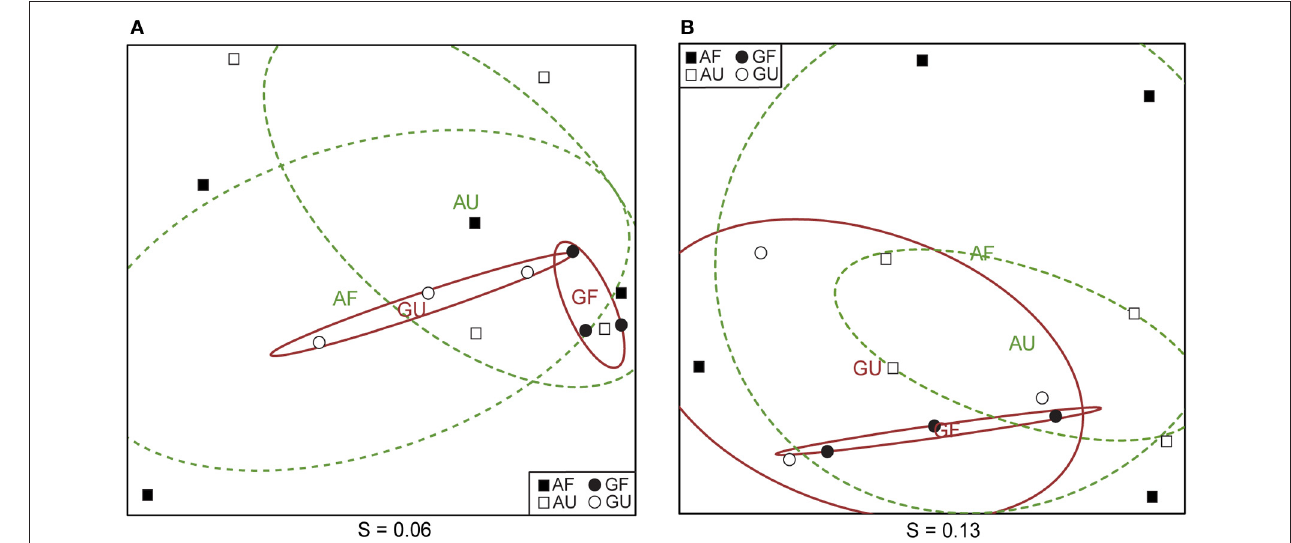
soils (dashed green lines, AF and AU). GF, geothermally heated and fertilized soil; GU, geothermally heated and unfertilized soil; AF, ambient temperature and fertilized soil; AU, ambient temperature and unfertilized soil. Both MDS routines applied by the metaMDS command were isoMDS, which utilizes PCO analysis as starting configuration. Stress values (S) are given below the figures, r 2 = 0 . 996 and 0.986 for (A) and (B) , respectively.